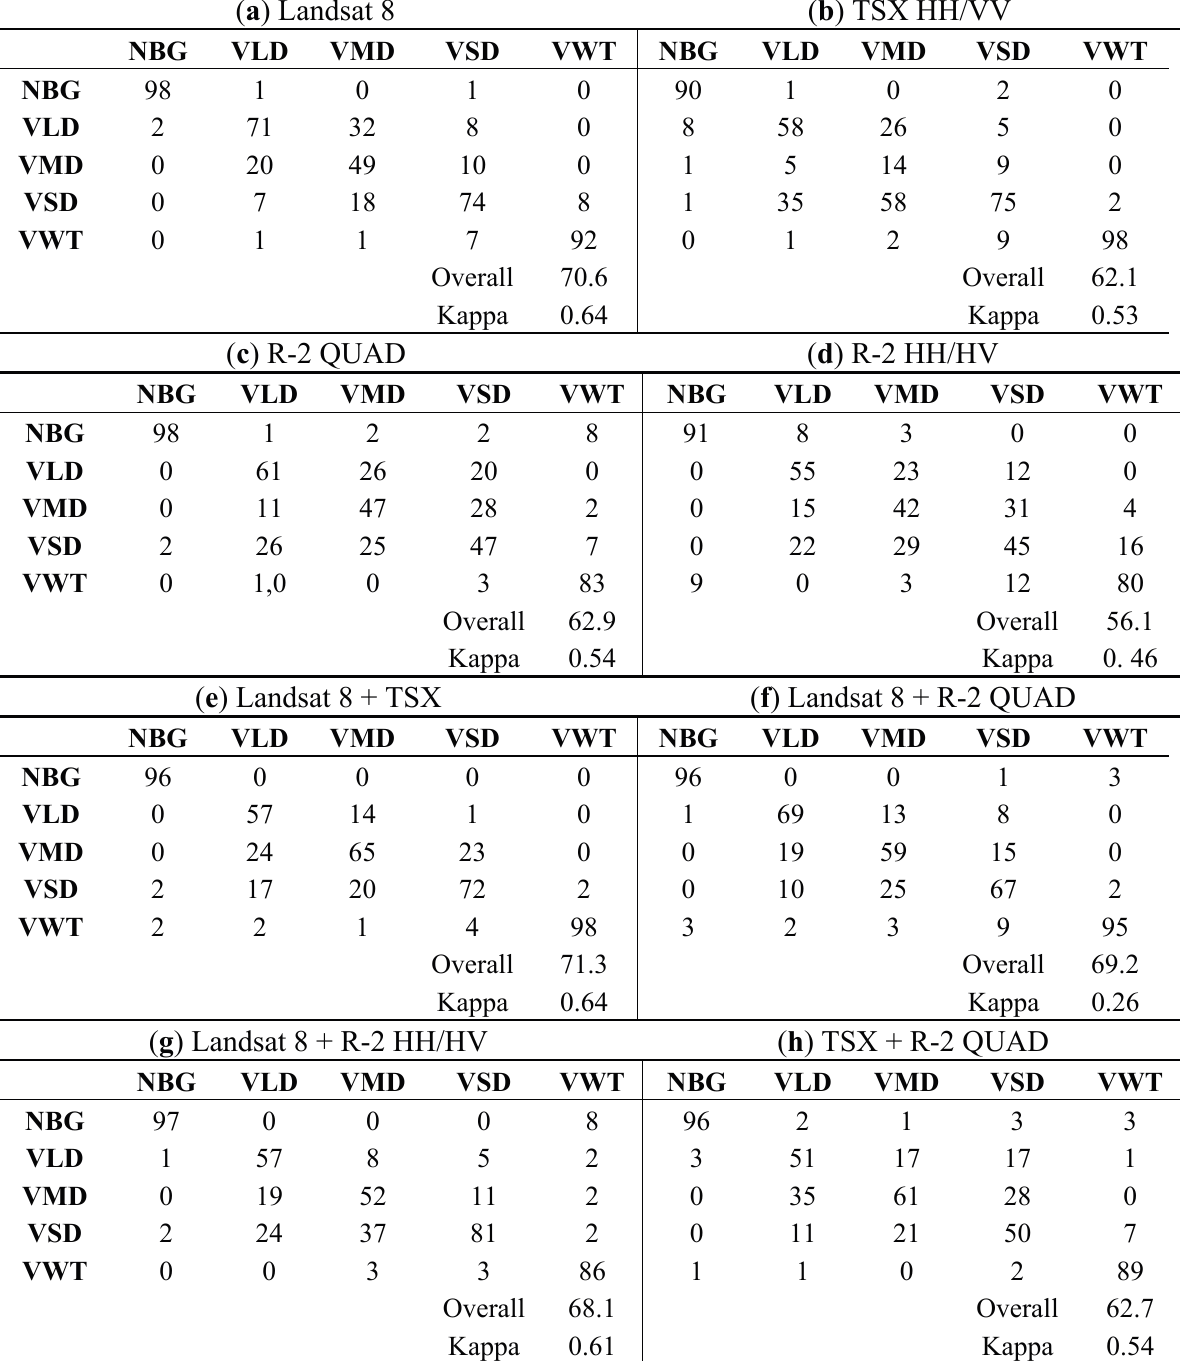
Table 2. Averaged Confusion Matrices from k-fold cross validation ( k = 5) for unsupervised land cover classification results ( a – h ). Accuracies are shown in percent